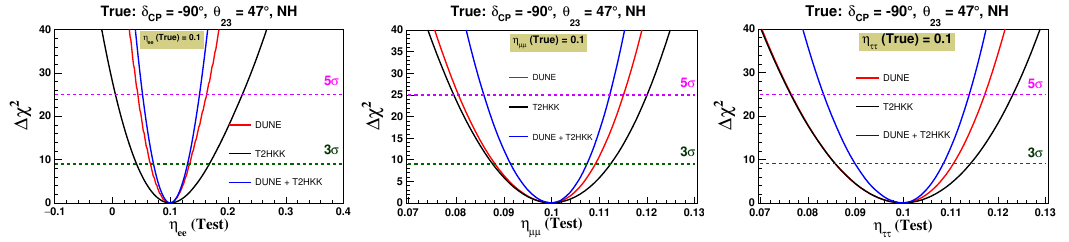
Figure 5 . The sensitivity of DUNE, T2HK and DUNE + T2HK towards constraining non-zero η ee (left-panel), η (middle-panel), and η (right-panel) at true δ = − π /2 and true θ = 47 ◦ . In µµ ττ CP 23 all the plots, the sensitivities for DUNE, T2HK and DUNE+T2HK are shown in red, black and blue respectively.